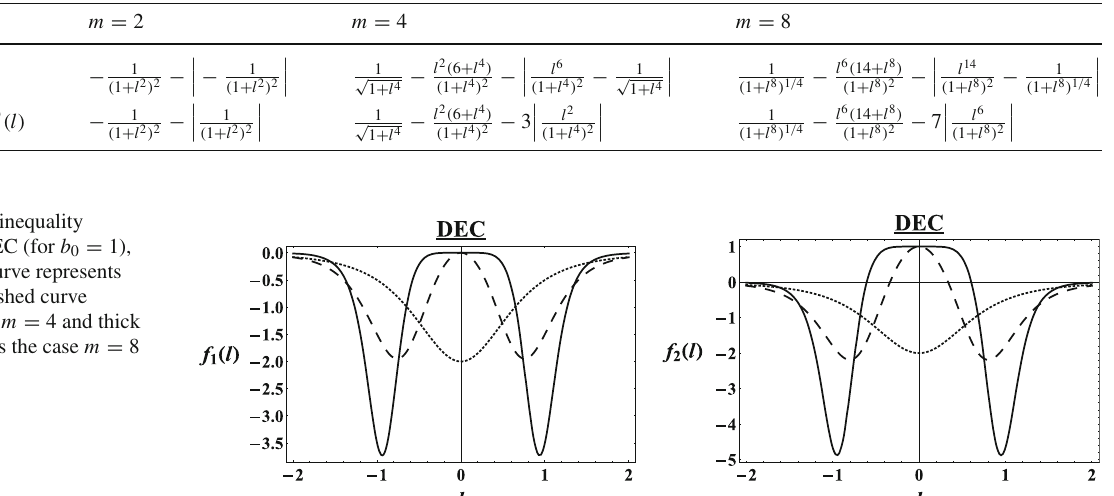
( i = 1 , 2 , 3) for m = 2, m = 4 and m = 8 i